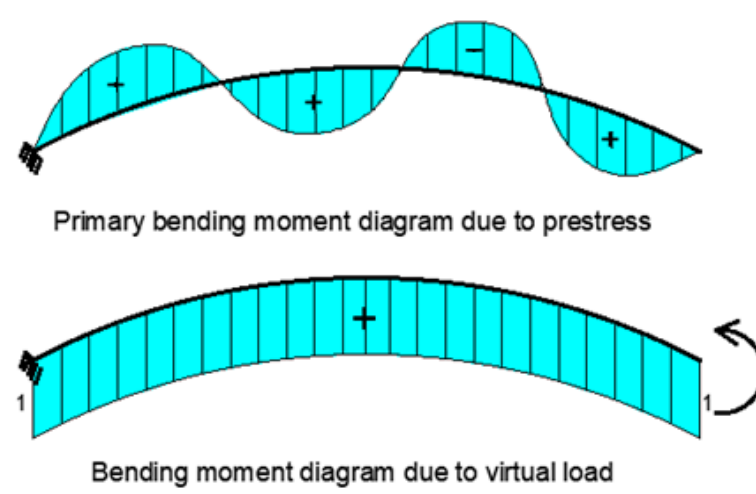
Figure 2. Application of the flexibility method for obtaining equivalent nodal loads.